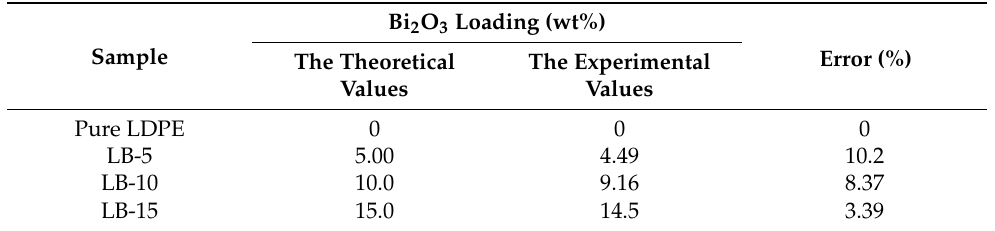
Table 3. Burn test of pure LDPE and LDPE + Bi 2 O 3 composites .